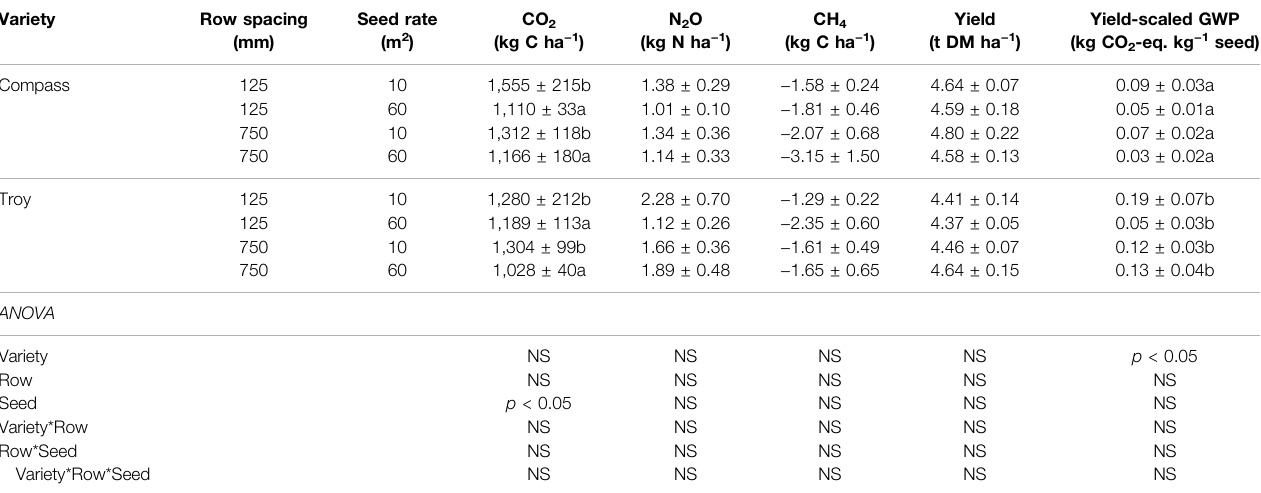
TABLE 4 | Cumulative GHG emissions, seed yield and yield-scaled GWP for Exp. 2. Variety